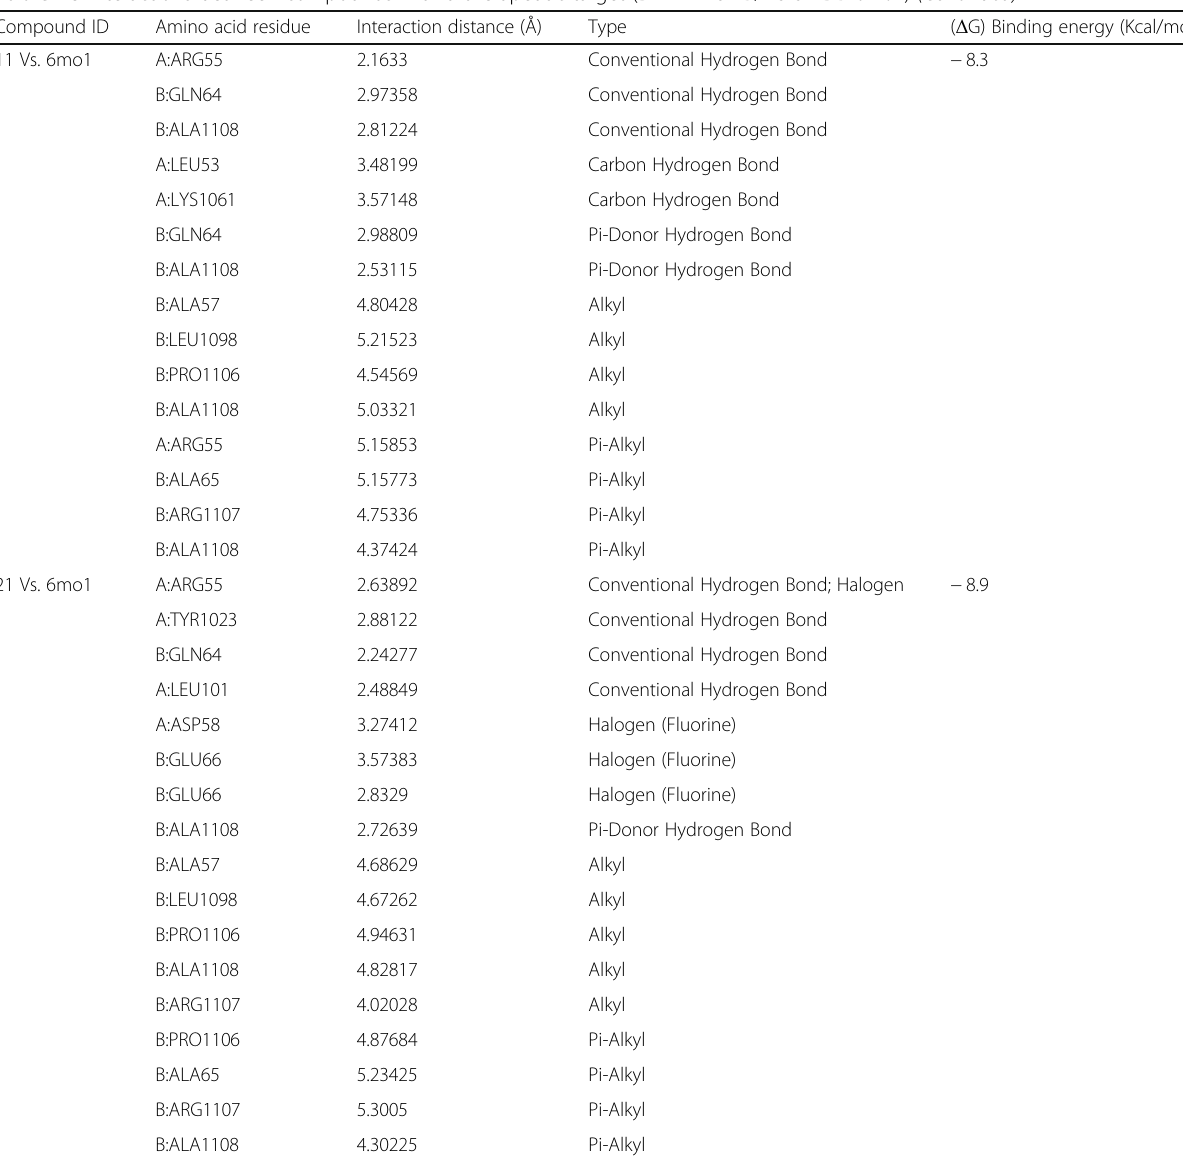
Table 10 Interactions between compounds with a therapeutic target (DNV-2-NS-2B/NS-3 PDB 6M01) (Continued) Compound ID Amino acid